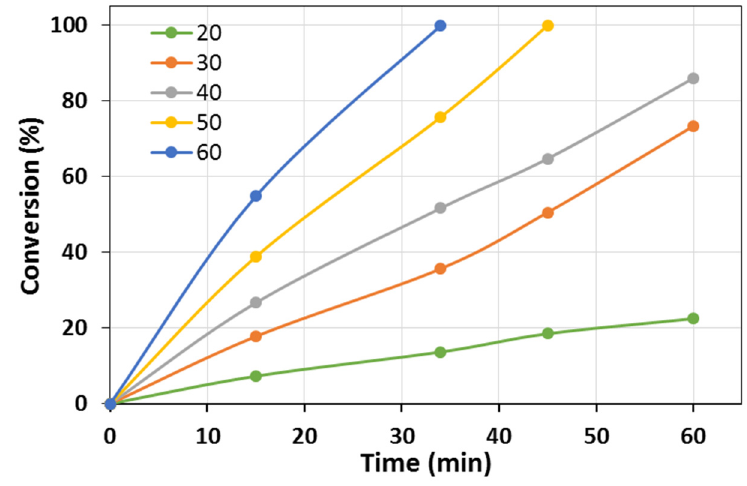
Figure 9. The conversion % profiles of cyclohexene over Pt-ZSM-5 at different temperatures as a function of the applied reaction time.